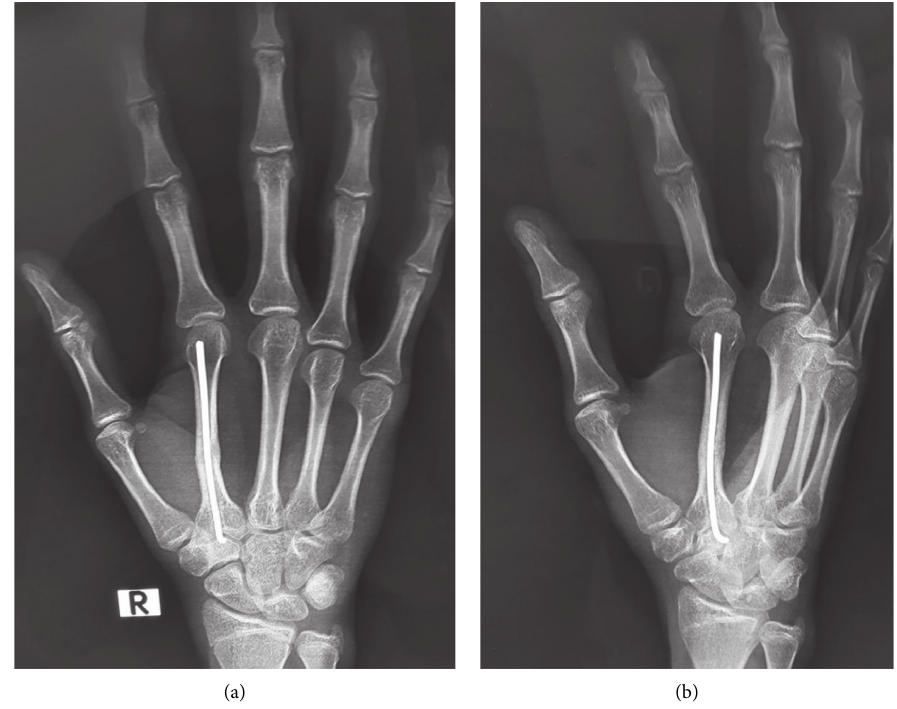
Figure 4: X-ray showing the 6-month follow-up of the patient, prior to K-wire removal.